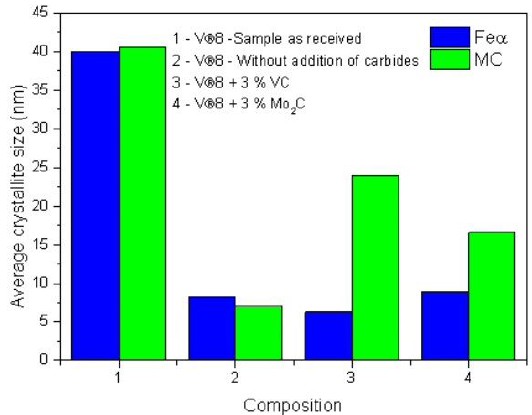
Figure 12: Average crystallite size of the Vanadis ® 8 pure and with additions of VC and Mo C after 12 hours of 2